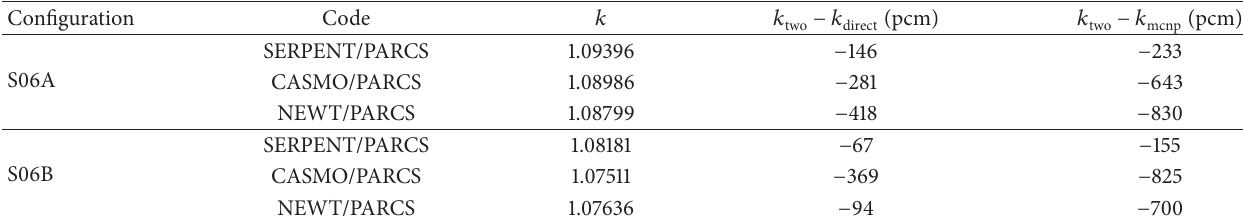
Figure 13: The quarter view of DIMPLE S06 two-step model. Table 8: The eigenvalue of DIMPLE S06 by 2D two-step modeling with ADF.